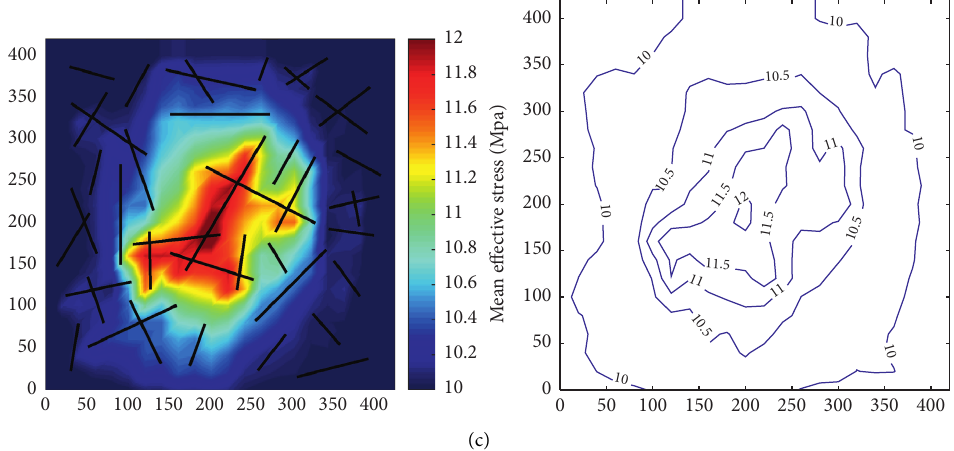
Figure 22: Mean effective stress distributions when (a) k